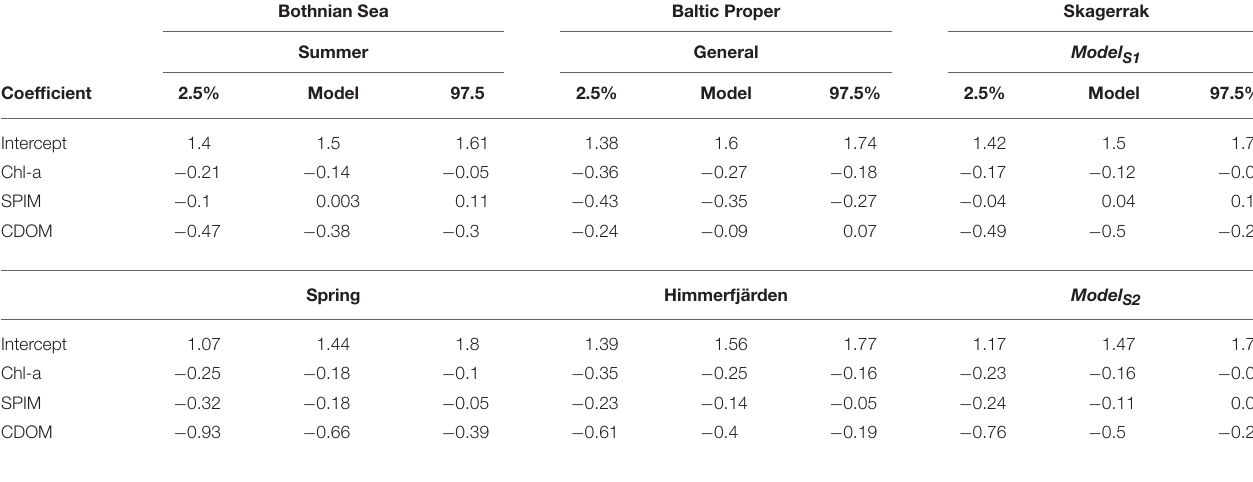
TABLE 6 | Table showing the 95 % Confidence Interval (CI) of the intercepts and coefficients for the models. Bothnian Sea Baltic Proper Skagerrak Summer General Model